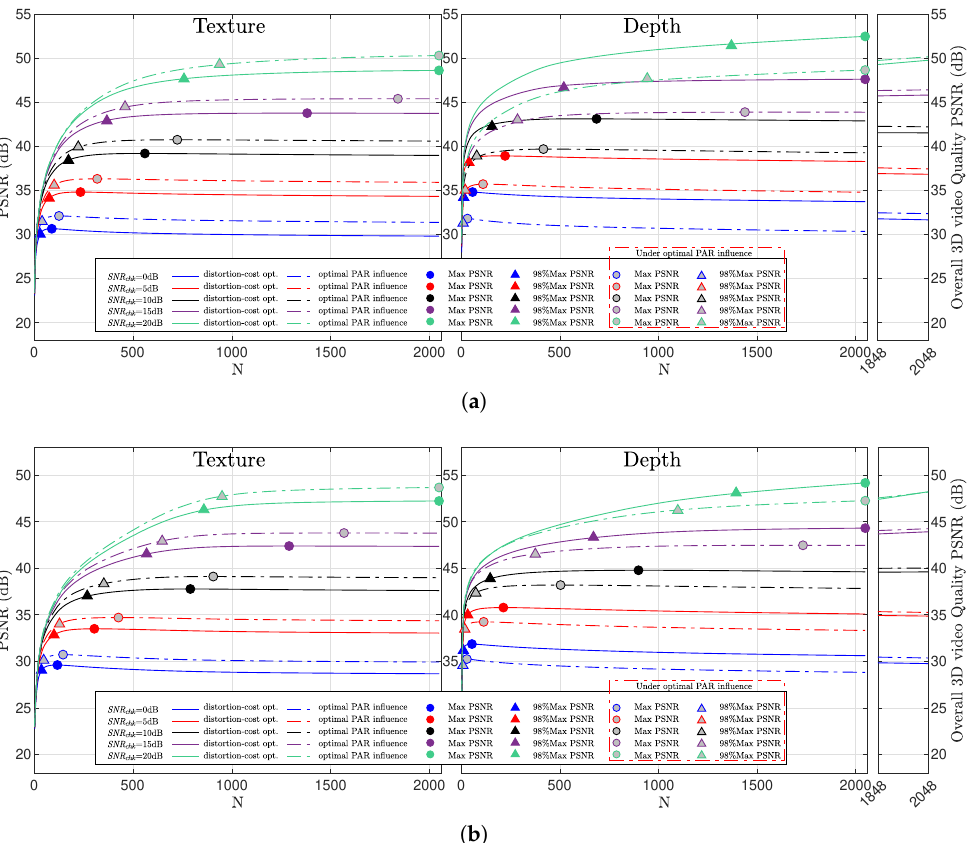
Figure 2. Minimum distortion optimization performance and PAR influence: ( a ) Kendo; ( b ) Poz-